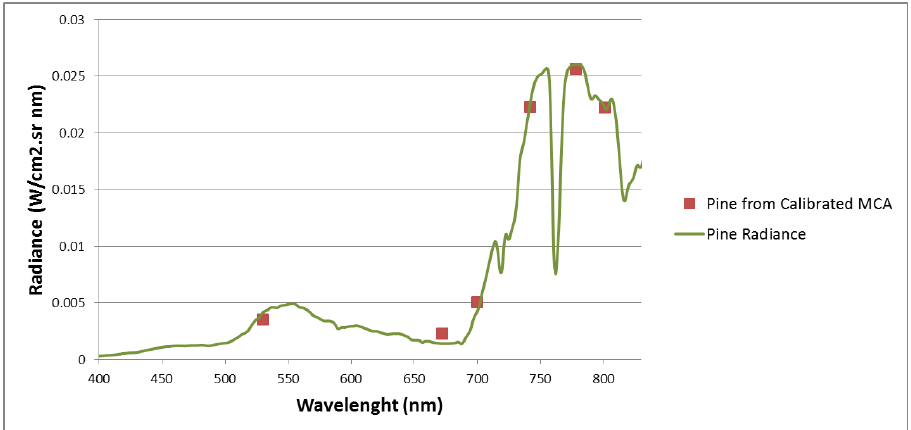
Figure 13. Pine radiance from the spectroradiometer and from the calibrated Mini